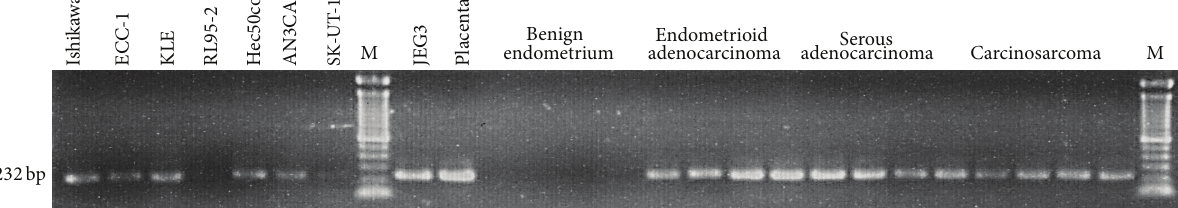
Figure 2: RT-PCR amplification of PLAC1 message in seven endometrial cancer cell lines and representative endometrial tumors ( 𝑛 = 4 each). Primers used for this assay are the Exon 5-6 pair (Table 2). JEG3 is a choriocarcinoma cell line known to express PLAC1 [8]. Placental tissue is from a normal 38-week delivery. Molecular weight markers (M) are Invitrogen Trackit 100 bp